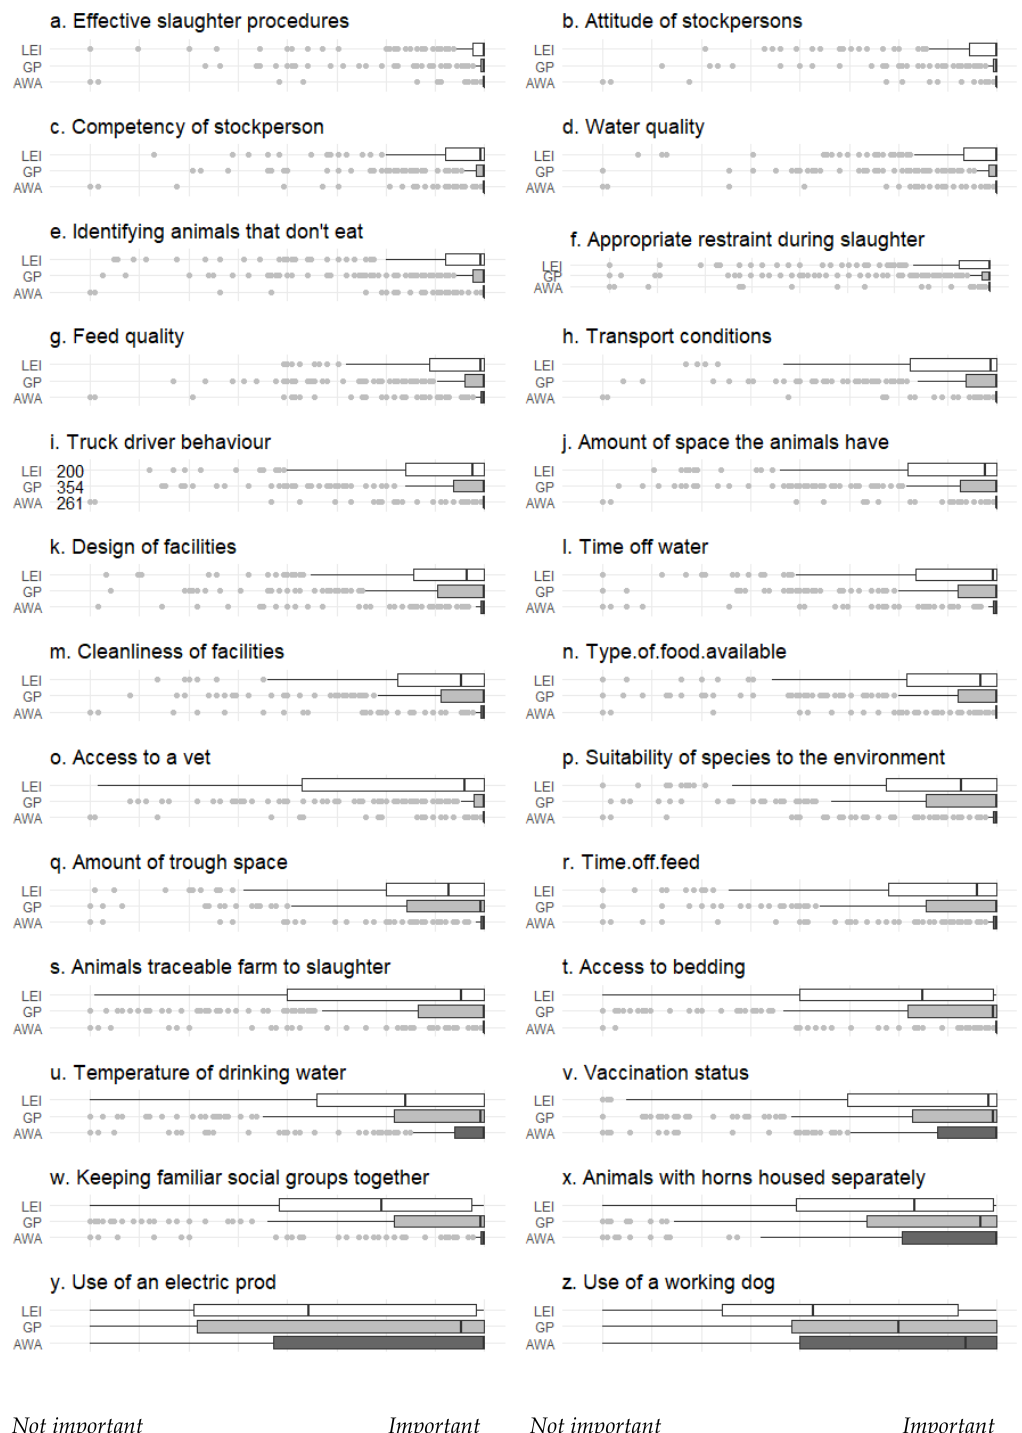
How important do you think these factors are for the welfare of livestock in the live export industry? Figure 6. Ratings of the importance of different welfare factors are in the live export industry by survey respondents grouped into three stakeholder categories: animal welfare advocates (AWAs), general public (GP) or live export industry (LEI) workers. Data were collected using a visual analogue scale: values are medians (vertical line) and quartiles (boxes) ± non-outlier range (whiskers); dots represent outliers (1.5 x the inter-quartile range). For all these questions, responses differed significantly between the three stakeholder groups (Kruskal–Wallis ANOVA; p < 0.001).